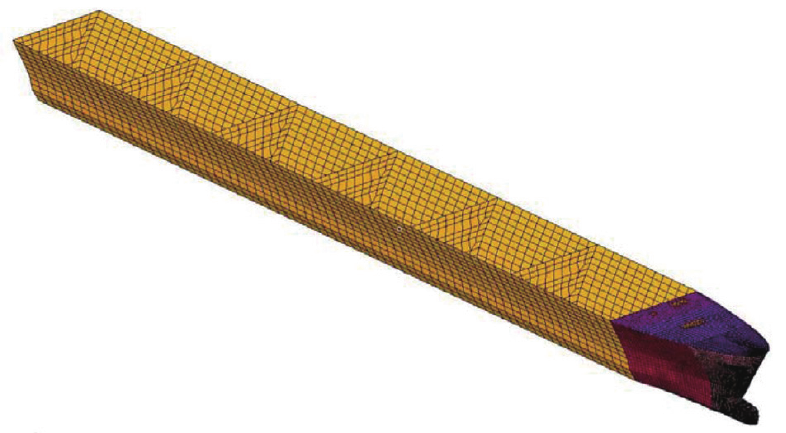
Fig. 6. Finite element model of the container vessel used in the